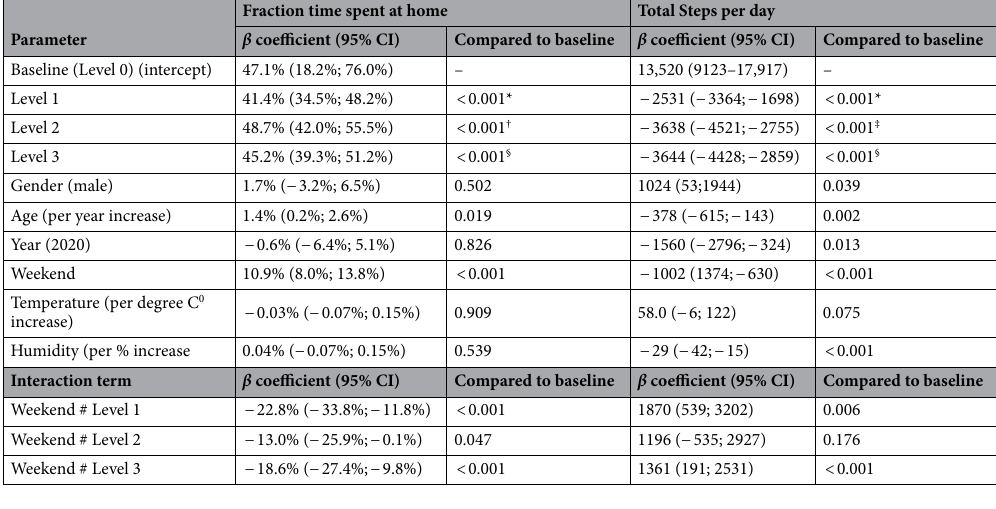
Table 3. Fraction time spent at home and total steps per day in response to interventions for Covid-19 among asthmatic children in Cyprus. * p < 0.001, compared to previous level. † p = 0.055, compared to the previous level. ‡ p = 0.021, compared to the previous level, § p > 0.05, compared to the previous level.